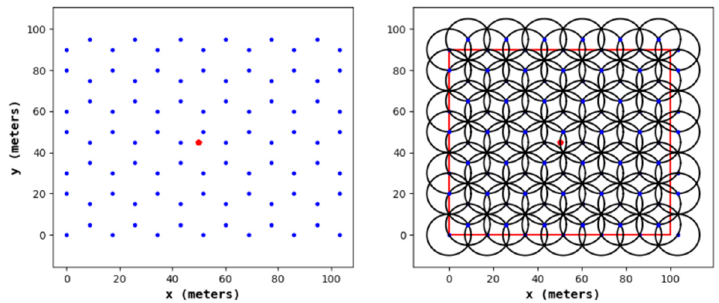
cellular network. a